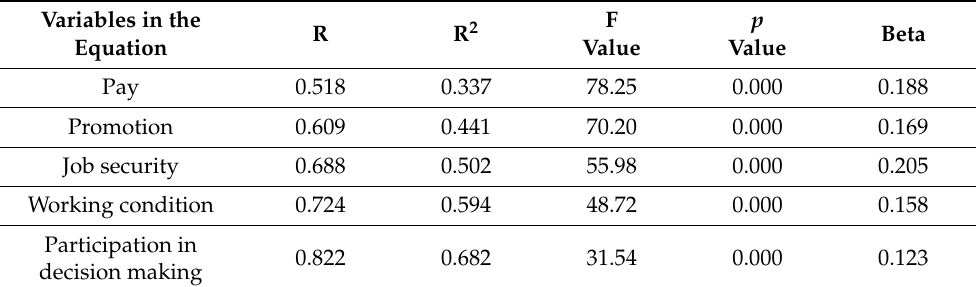
Table 12. Summary of step-wise multiple regression: dependent variable job